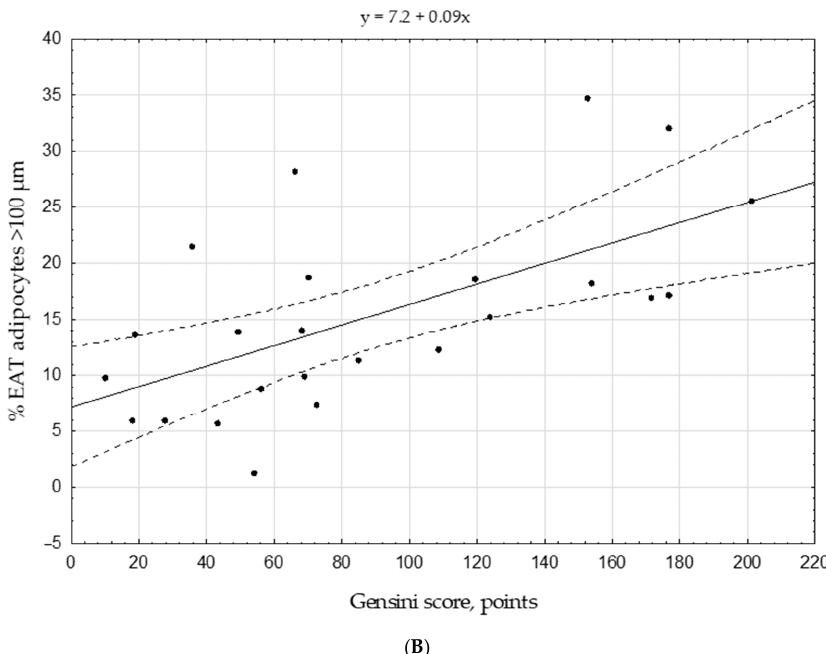
Figure 3. Scatter plots displaying the size of EAT adipocyte ( A ) and the proportion of hypertrophied adipocytes ( B ) related to the Gensini score. Note: EAT, epicardial adipose tissue. Gensini score was adjusted to gender.